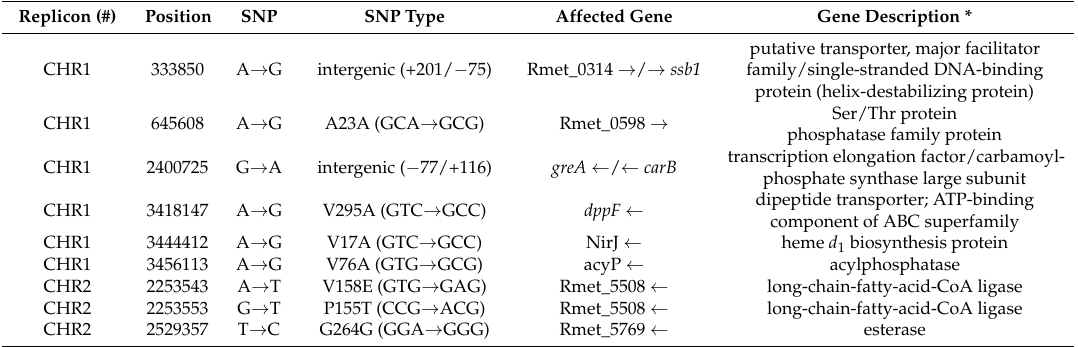
Table 3. Single nucleotide polymorphisms (SNPs) detected in the genome of C. metallidurans MSR33. Replicon (#)